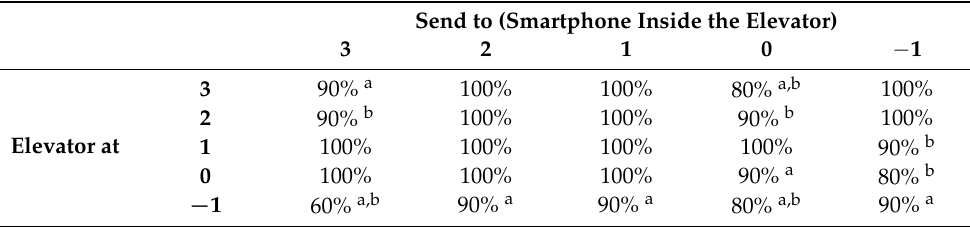
Table 3. Success rate when accessing to the IoT device controlling the elevator with a smartphone from inside the